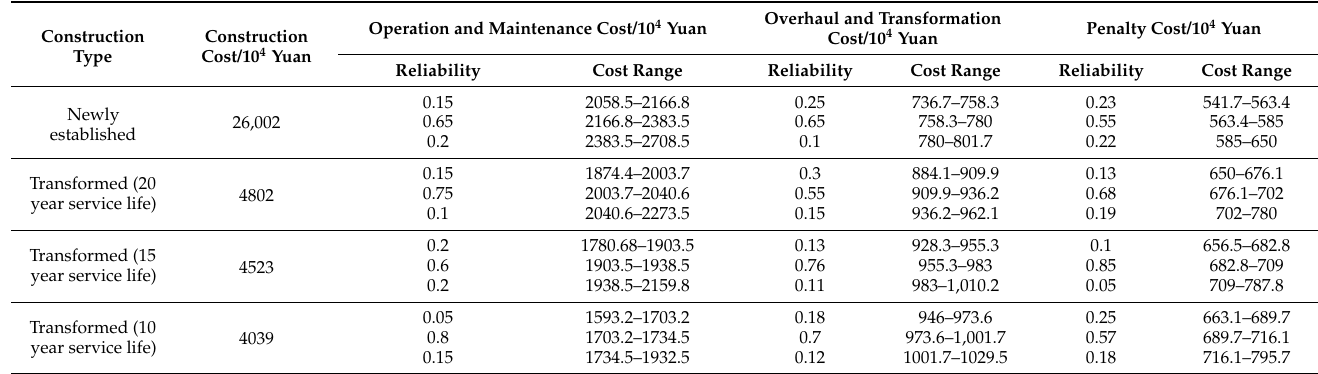
Table 1. Life-cycle cost of the NESC and the SCTTU with different service